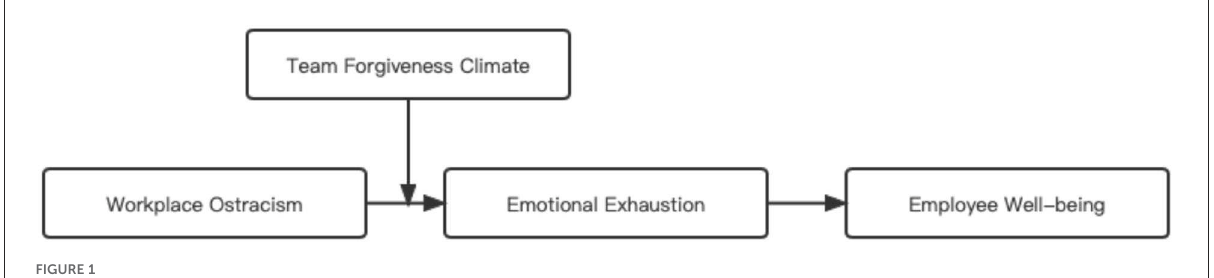
FIGURE1 Research framework—a theoretical model.